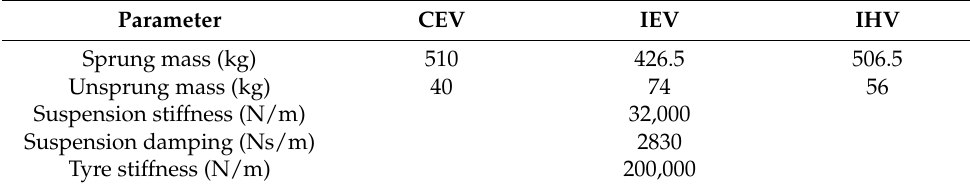
Table 5. Model parameters of different vehicles.